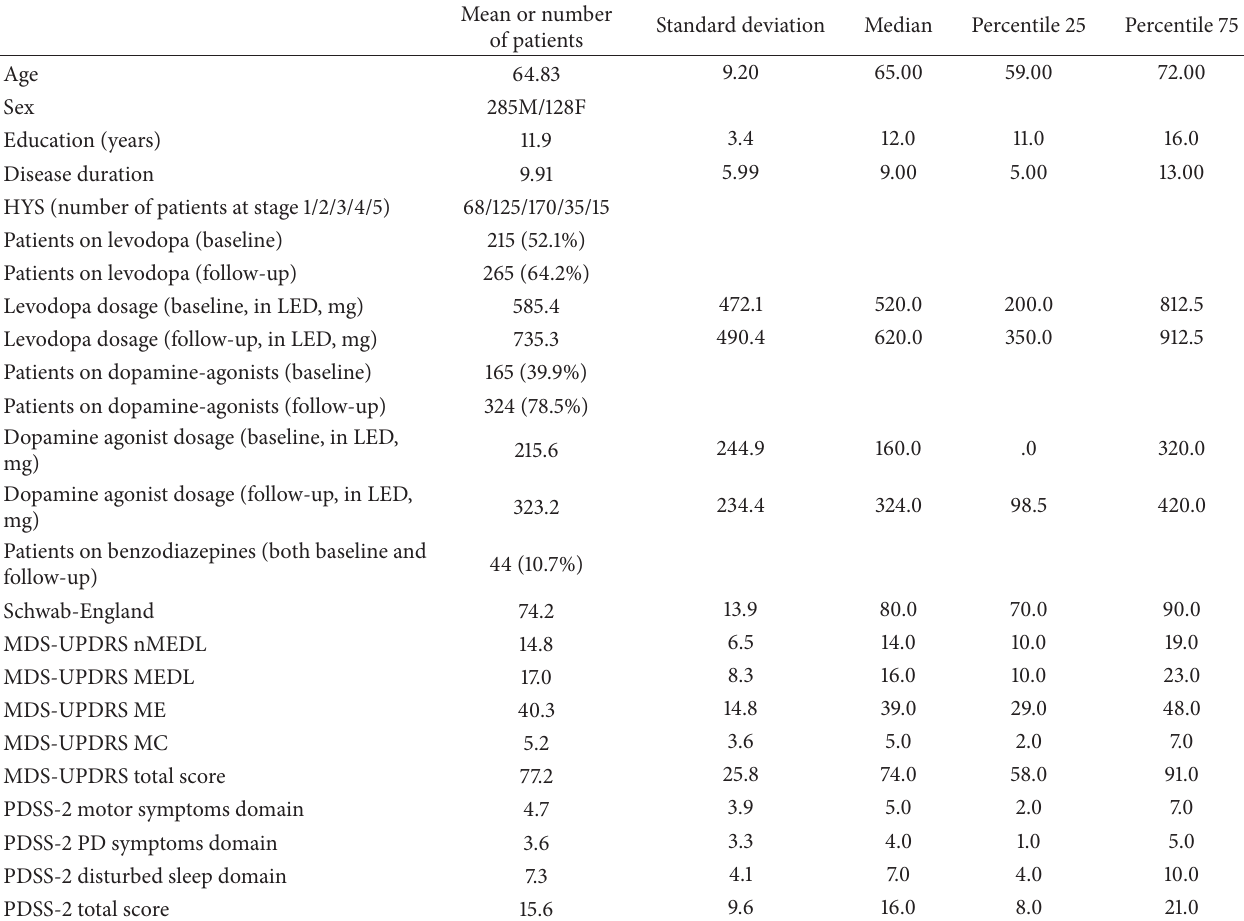
Table 1: The demographic and disease-specific characteristics of the study population ( 𝑛 = 413 ) at baseline